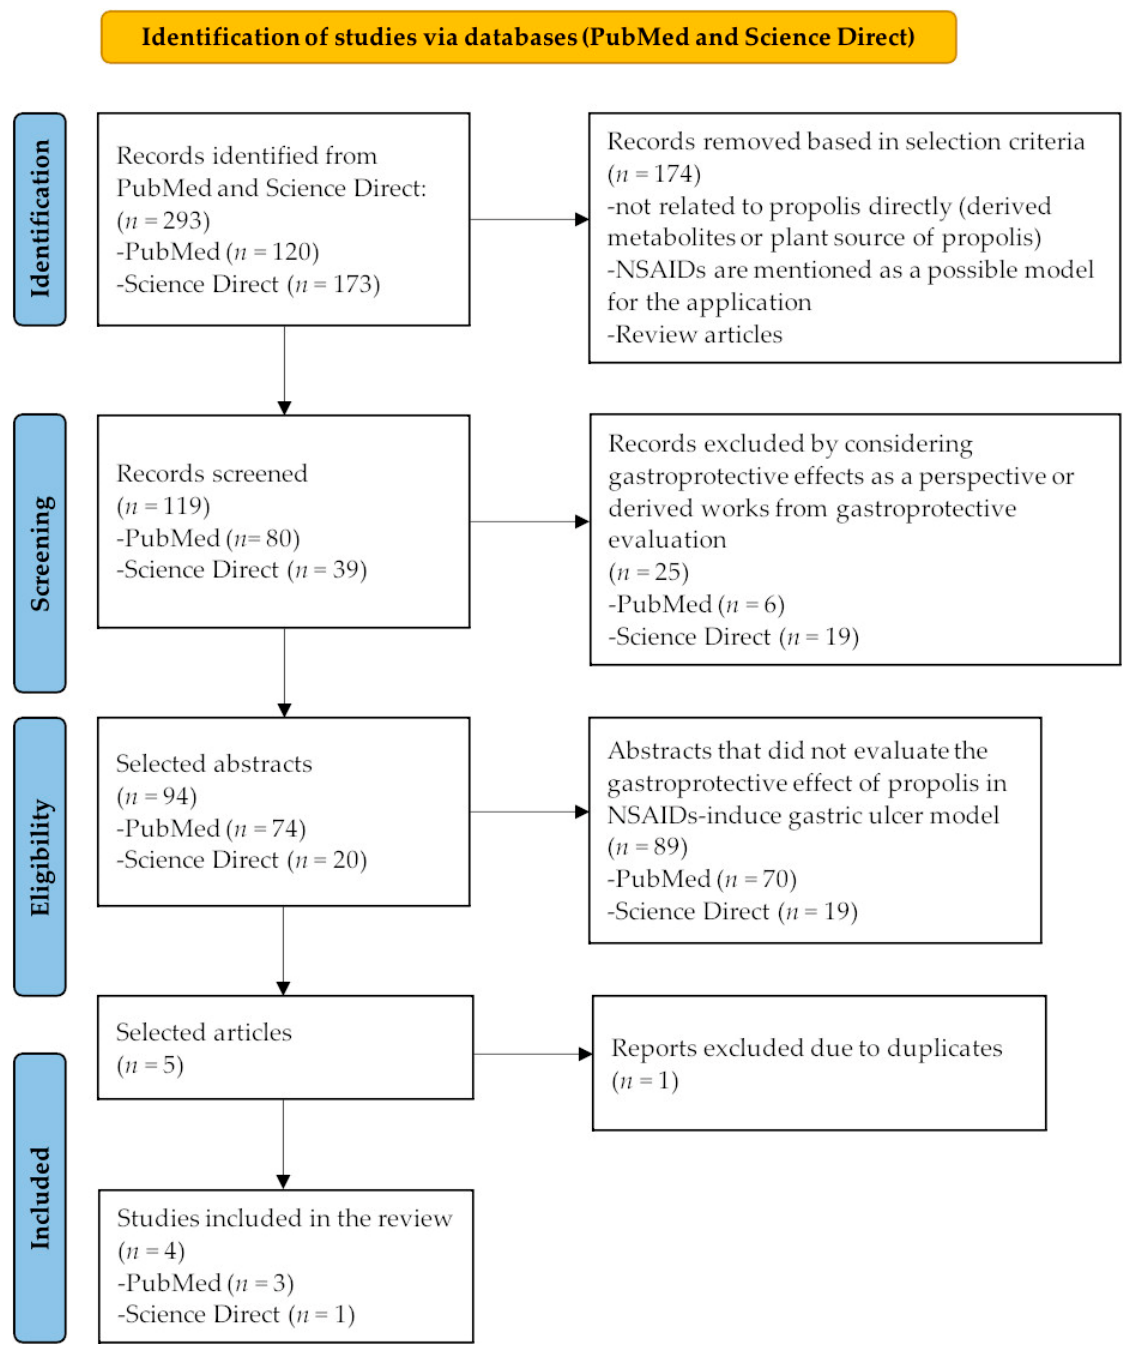
Figure 1. PRISMA flow diagram to show the literature selection process in PubMed and Science Direct databases used in this review.